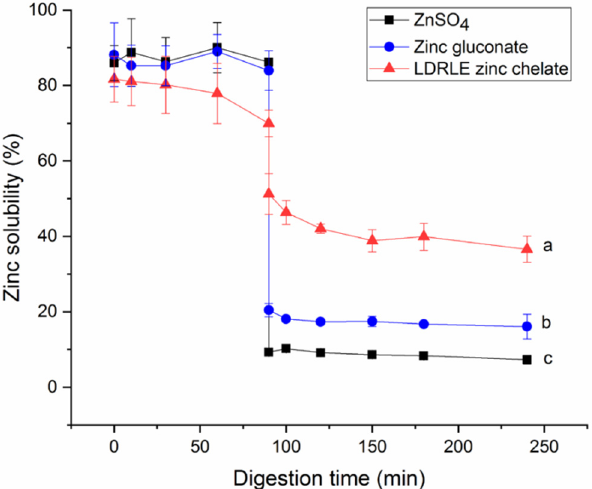
Figure 9. Zinc solubility stability of LDRLE-zinc chelate, zinc sulphate and zinc gluconate against simulated gastrointestinal digestion at 37 °C. The digestion at pH 2.0 during 0 to 90 min, and at pH 2.0 during 91 to 240 min. Different lowercase letters (a–c) near the lines indicate significant differences ( p < 0.05).